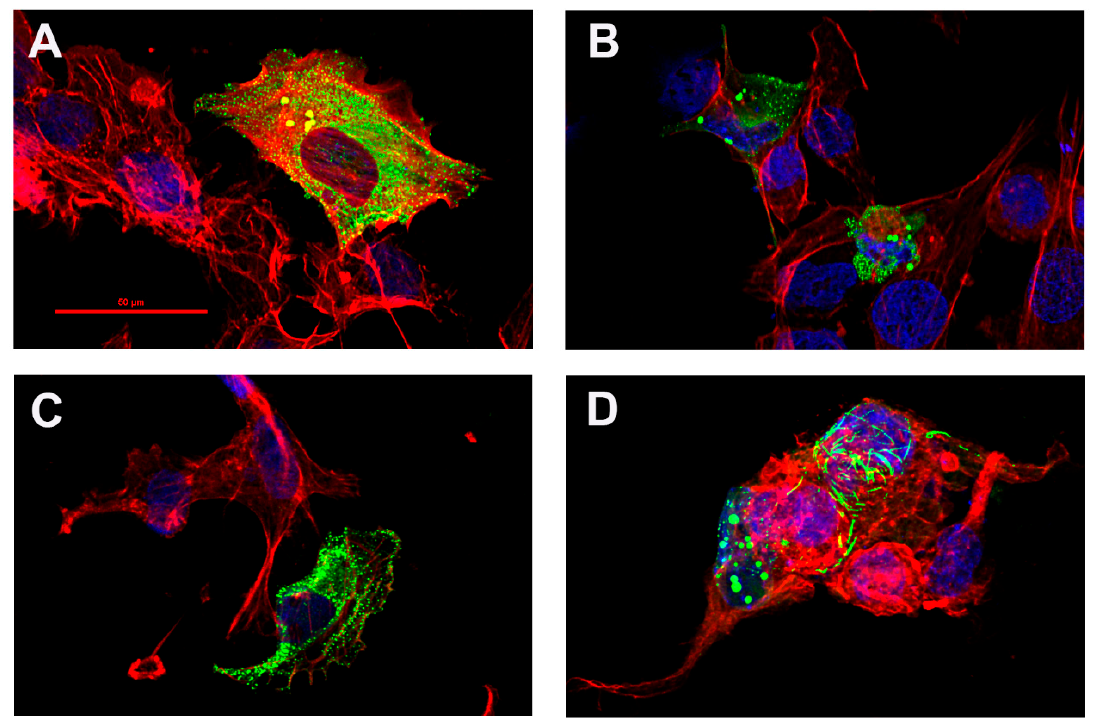
Figure 6. ABI3-GFP expression in HMC3 cells results in “ribbon” formations with the D-Exon6 isoform. Each isoform was expressed as ABI3-GFP fusion proteins (green) in HMC3 cells co-labelled with phalloidin (red) and DAPI (blue). The FL-ABI3 ( A ), D-3bp ( B ), and D-69bp ( C ) isoforms manifested in cells as small, dispersed puncta. The D-Exon6 ( D ) isoform formed large aggregates and unique “ribbon” formations often. Color-separated images for this figure are included as Supplemental Figure S1.